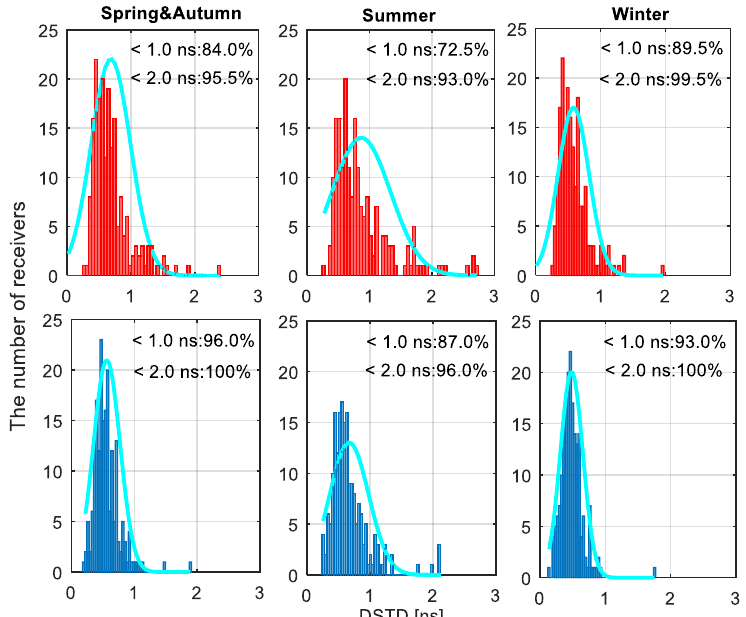
Figure 8. The distribution of the intraday stability DSTD of the estimated receiver DCBs determined using MCCL in different seasons of 2014 (red) and 2017 (blue). The vertical axis stands for the number of selected receivers and the horizontal axis stands for the DSTD of receiver DCB estimates.